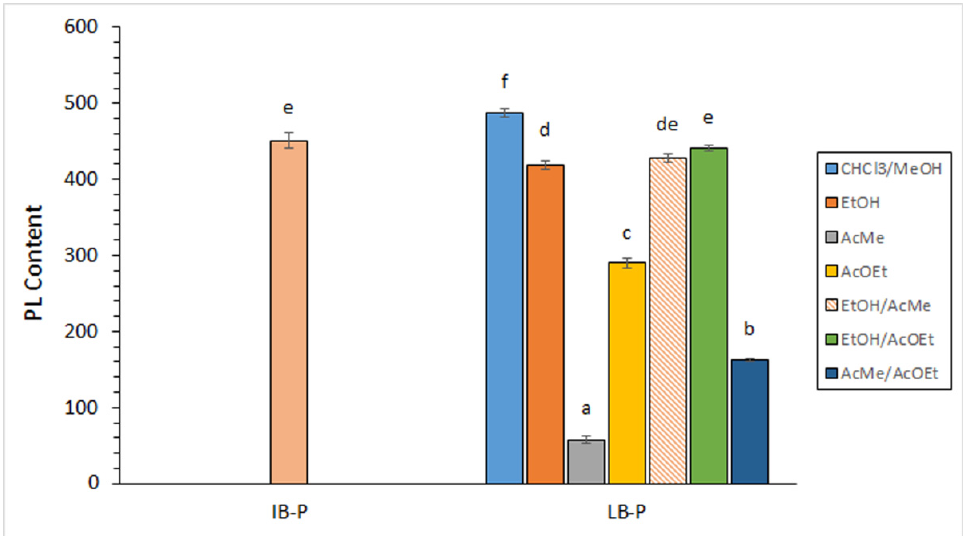
Figure 1. Determination of phospholipid (PL) content (g·kg − 1 lipids) in initial by-products (IB-P) and lyophilised by-products (LB-P) obtained by different lipid-extracting systems. Average values of three independent determinations ( n = 3); standard deviations are indicated by bars. Values accompanied by different lowercase letters (a–f) indicate significant differences ( p < 0.05). Extracting systems as expressed in Table 1.